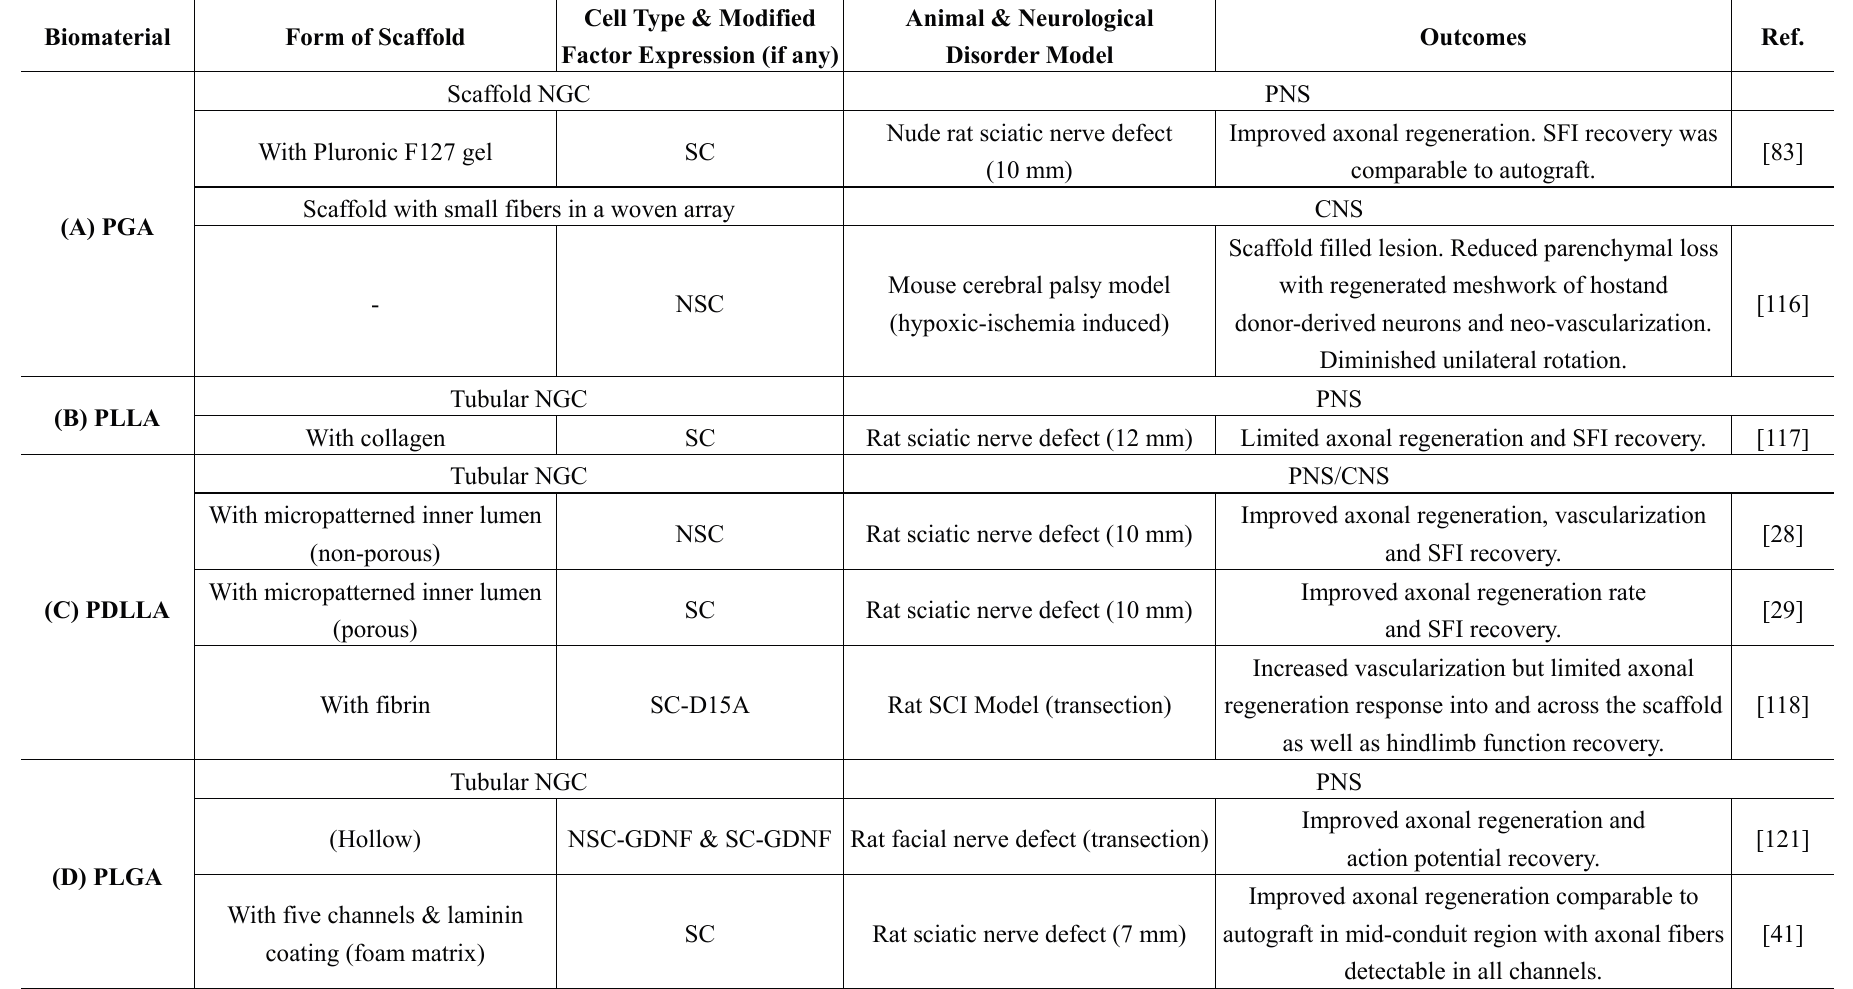
Table 2. Examples of synthetic, biodegradable polyester cell-carriers used in vivo in preclinical